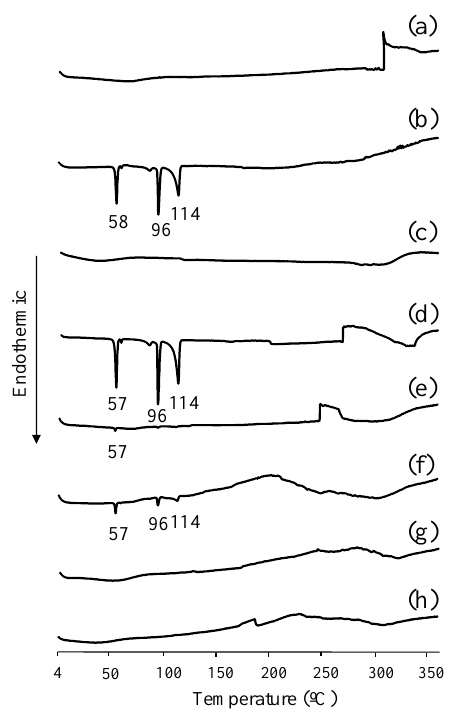
Figure 8. DSC curves of Sol/ASC-DP systems. ( a ) Sol, ( b ) ASC-DP, ( c ) EVP (Sol), ( d ) EVP (ASC-DP), ( e ) PM (Sol/ASC-DP = 9/1), ( f ) PM (Sol/ASC-DP = 8/2), ( g ) EVP (Sol/ASC-DP = 9/1), and ( h ) EVP (Sol/ASC-DP = 8/2).